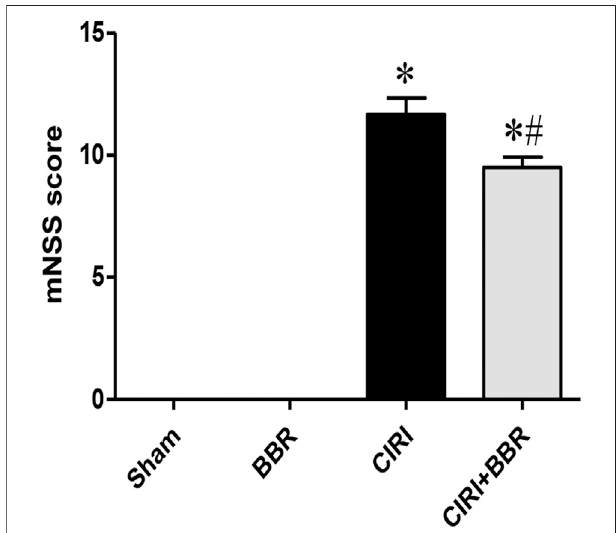
FIGURE 1 | BBR improves neurological dysfunction induced by CIRI. After 24 h of reperfusion injury, neuroethology was evaluated by the Modi fi ed Neurological Severity Score (mNSS). Data are shown as the mean ± SEM, n (cid:2) 12 per group. * p < 0.05 compared with Sham group; # p < 0.05 compared with the CIRI